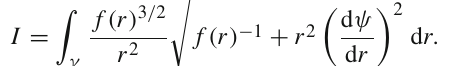
Fig. 7 with w = − 0 . 5 (top row) and w = − 0 . 7